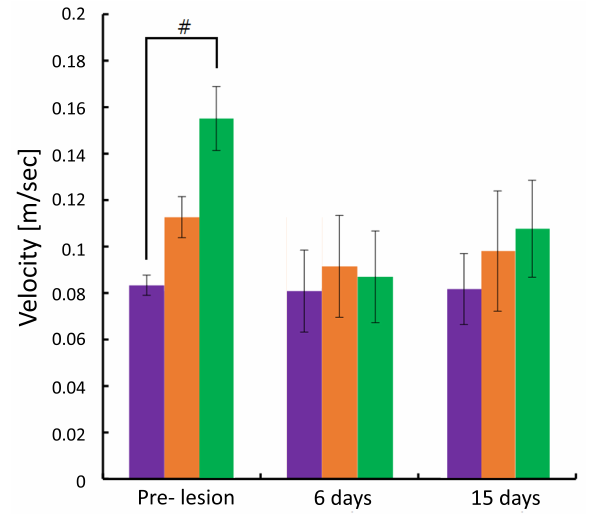
Fig. 9. Changes in hand movement speed. The time from maximal fin- ger opening to pellet grabbing is divided into three equally long phases: the initial, middle, andfinalphaseofthehandmovement(purple, initial; orange middle; and green, final). The hand-closing velocity significantly increases from the initial to the final phase before the lesion (Tukey-Kramer’s test, # p < 0.05). However, this acceleration is almost completely suppressed after the cortical lesion. Data are represented as mean ±